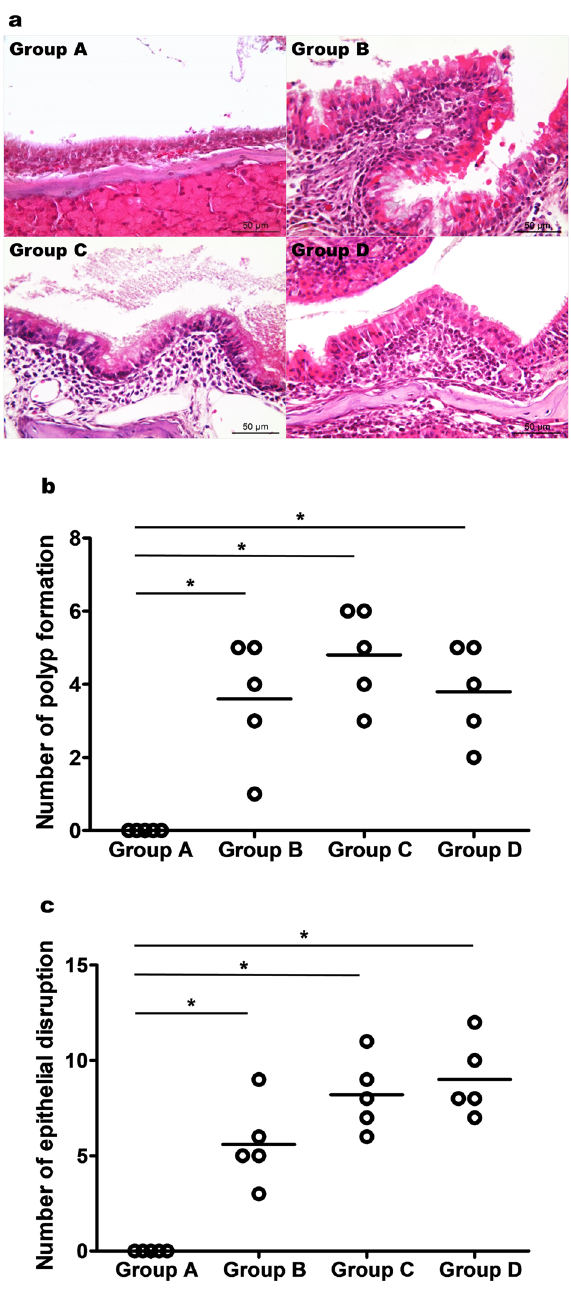
Figure 1. Histologic results of the development of polyps and epithelial disruptions. ( a ) Representative Hematoxylin & Eosin staining of the different experimental groups’ preparations. ( b ) Polyp formations and ( c ) epithelial disruptions. The data were plotted using GraphPad Prism version 5 (GraphPad Software Inc., San Diego, CA., USA, https ://www.graph pad.com). Group A: negative control, Group B: positive control, Group C: LPS stimulation, Group D: poly(I:C) stimulation. *P <